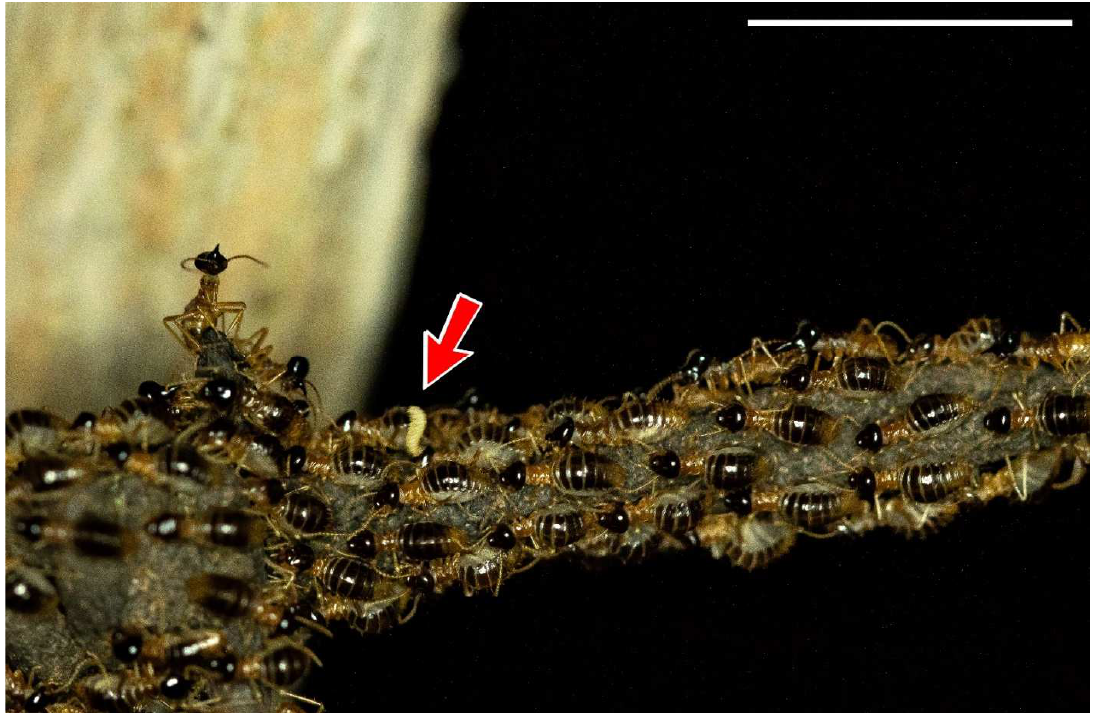
Figure 6. Foraging trail of Constrictotermes cyphergaster (Blattodea, Termitidae). The arrow shows a Corotoca sp (beetle that lives only inside the nests of C. cyphergaster in the semiarid areas of South America) larva being carried by a termite worker. Scale bar on the top right = 1 cm.